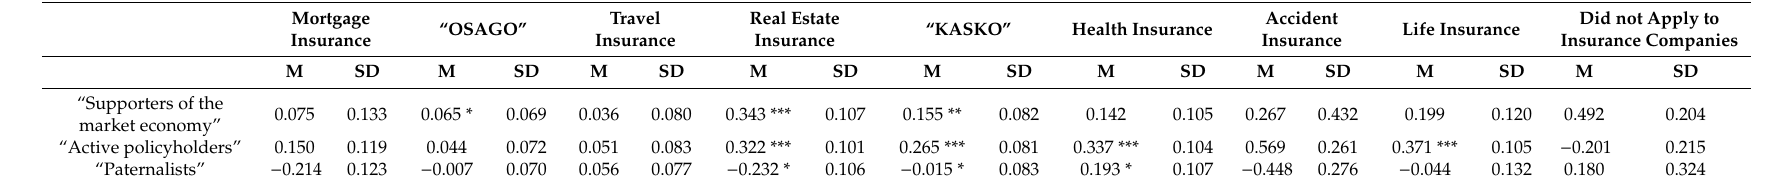
Table 1. Significant di ff erences between groups using insurance products (N =